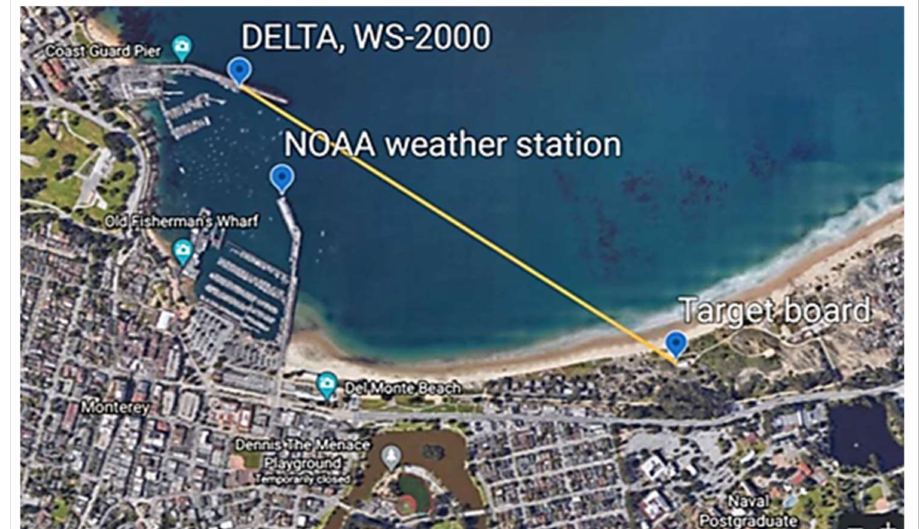
Figure 3. The laser propagation path over Monterey Bay, CA. The MZA DELTA transmitter is located on the Coast Guard Pier (upper left) and the target board is on a coastal